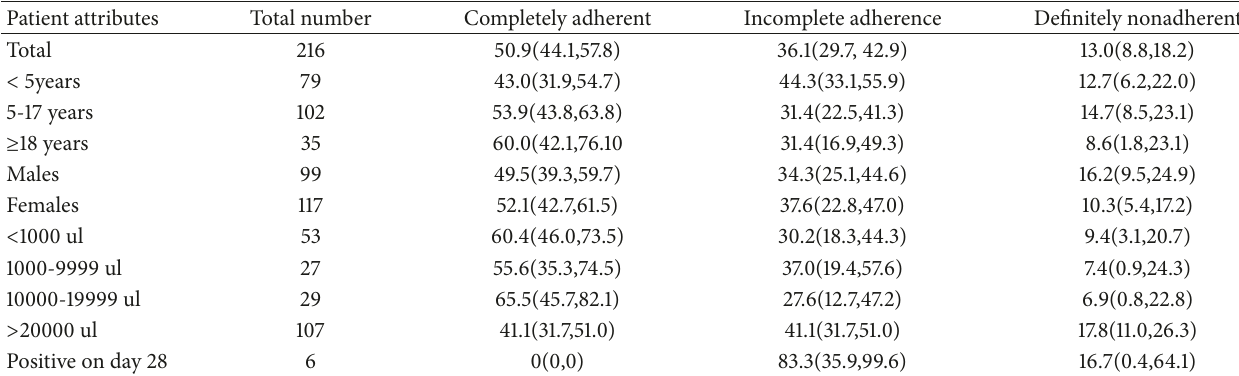
Table 2: Classification of patient adherence by patient